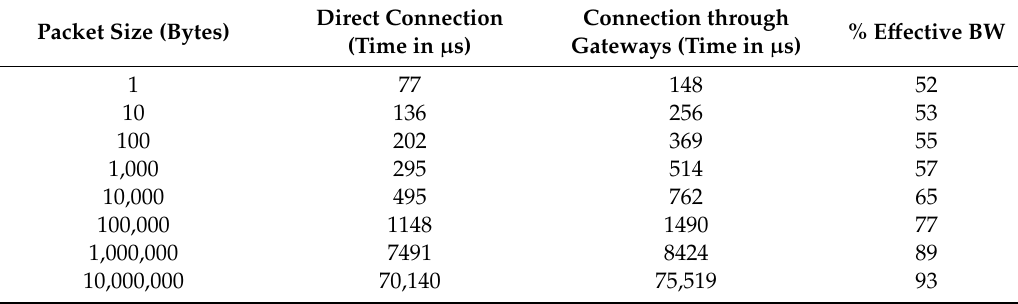
Table 11. Transfer time on Intel(R) Xeon(R) CPU E5-2620 v4 @ 2.10 GHz, CentOS 7.7.